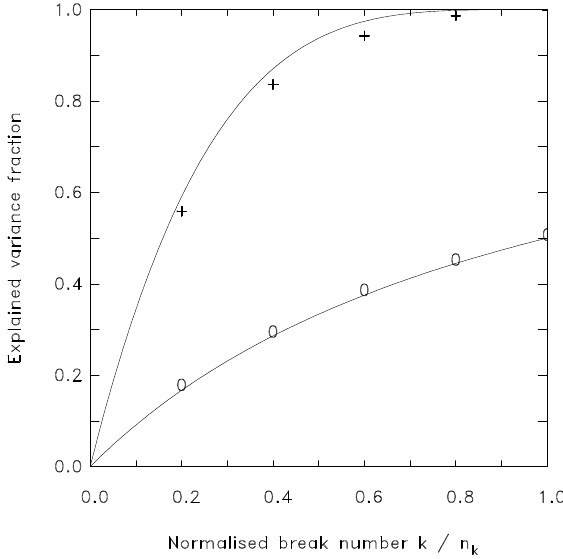
Figure 5. Empirical estimates of the external variance as a function of the normalized number of tested breaks for random (0) and op- timum ( + ) segmentations. Analytical functions (Eqs. 7 and 8) are given for comparison, similar to Fig. 3, but for a pure break sig- nal and with a different normalization. The empirical estimates are based on 1000 simulated time series of length 100 with five breaks at random